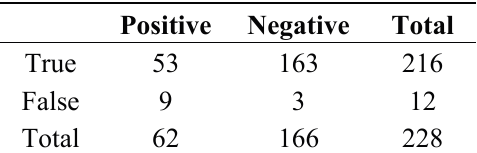
Table 3. The accuracy of the nest usage sensor in the detection of a double nest occupation during an